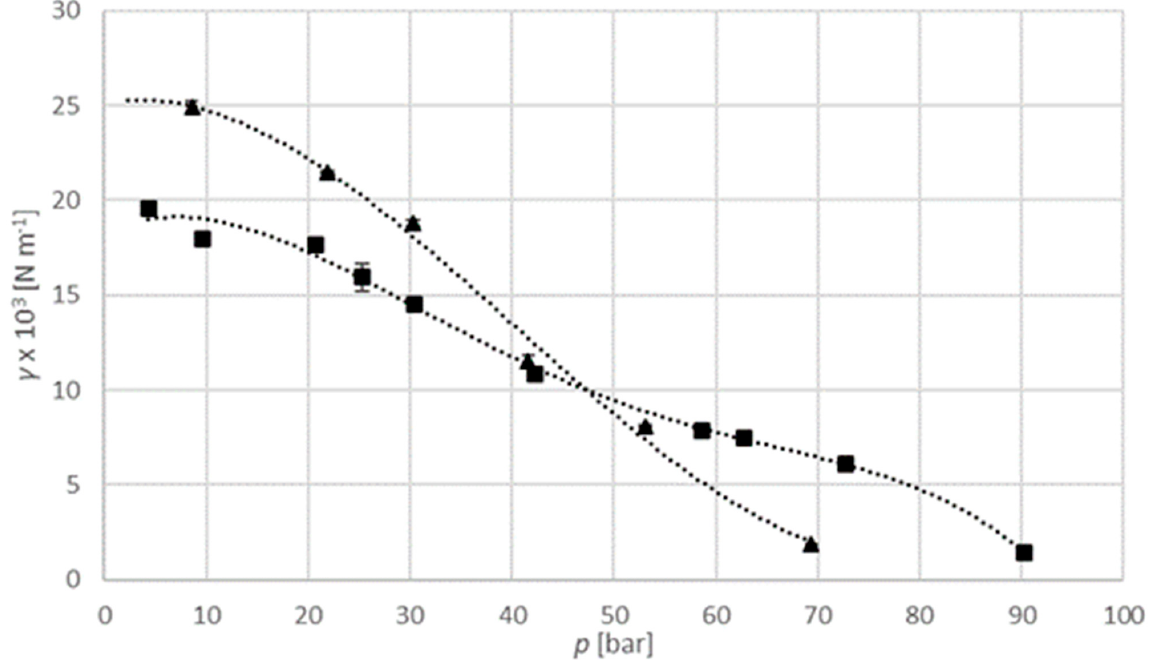
Figure 4. The viscosity of pure gas as a function of pressure in comparison to literature data: , measured data at 313.15 K; , measured data at 333.15 K; X, pure gas at 313.15 K [16]; , pure gas at 333.15 K [16].